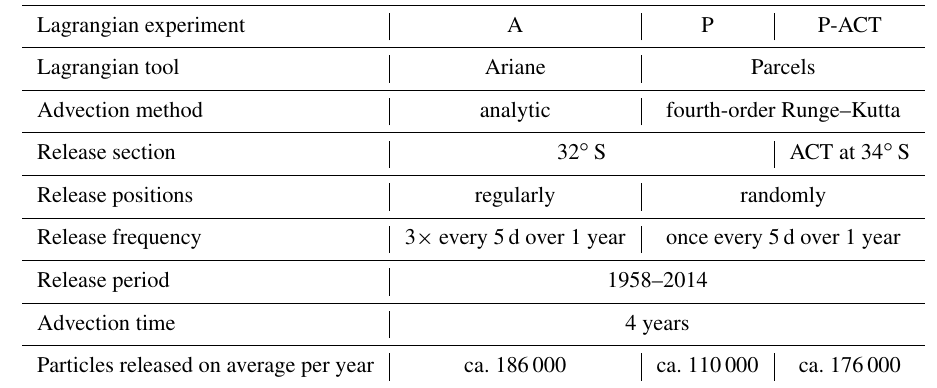
Table 1. Parameters of the Lagrangian